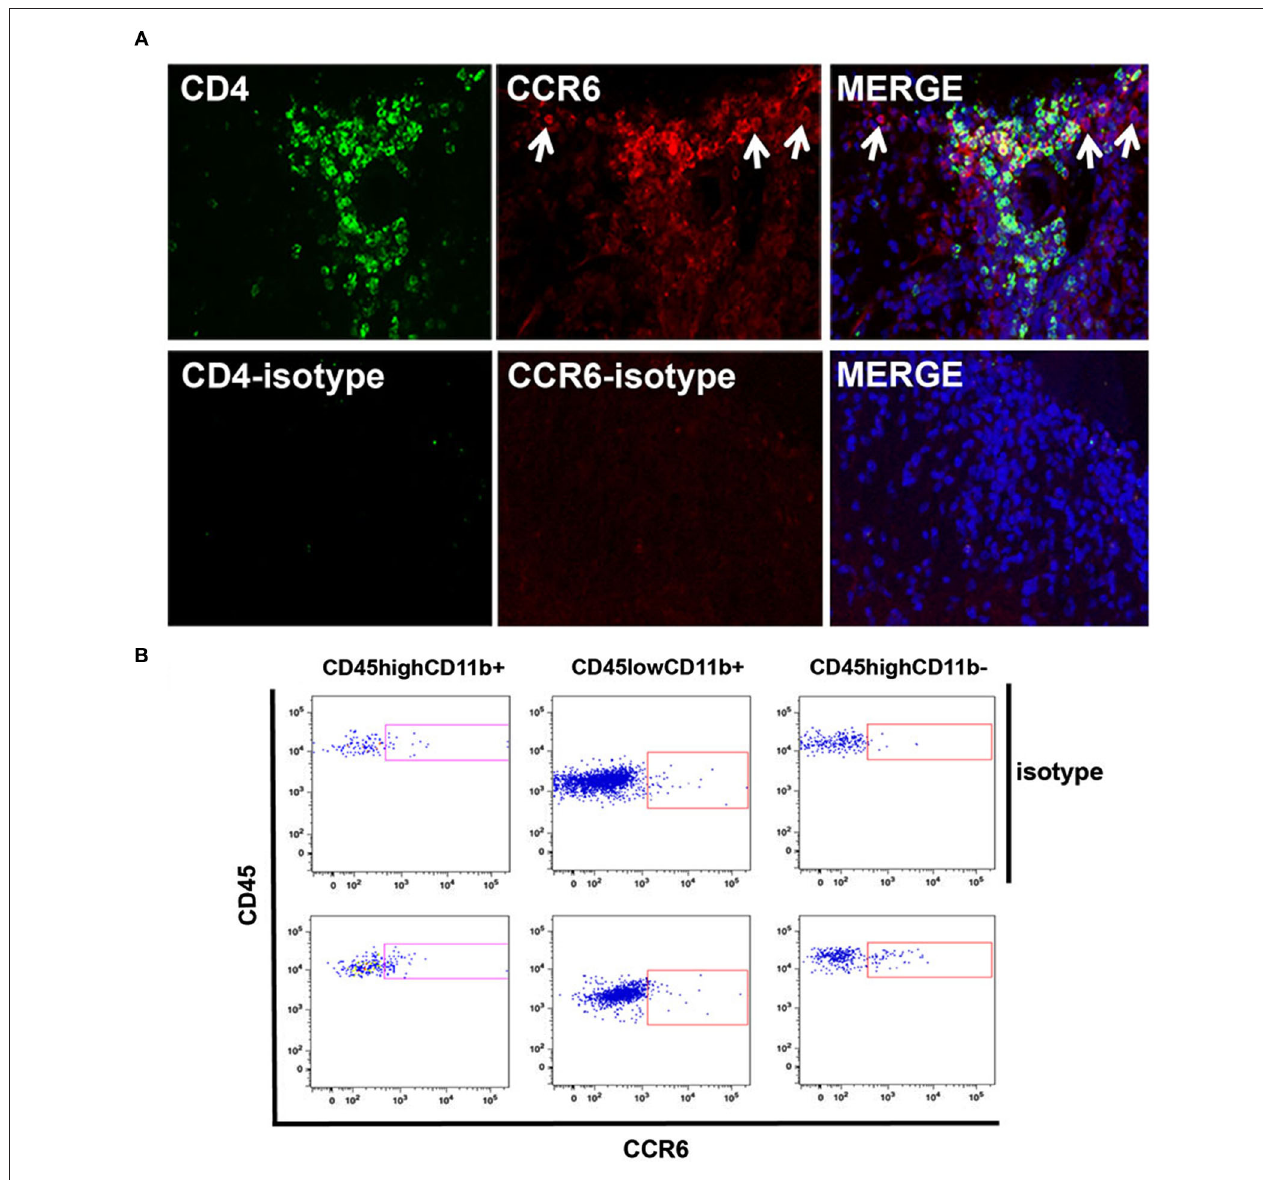
Non-specific staining was evaluated by replacing CD4 and CCR6 antibodies with isotype-matched negative control antibodies. (B)